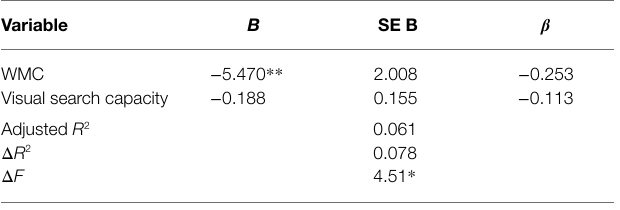
TABLE 3 | Summary of the standard multiple regression for resumption lag in uninterrupted trials. Variable